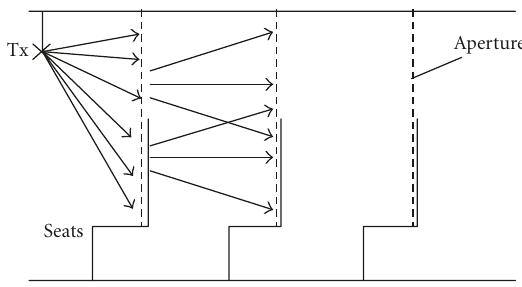
Figure 10: Schematic diagram of the modeling approach